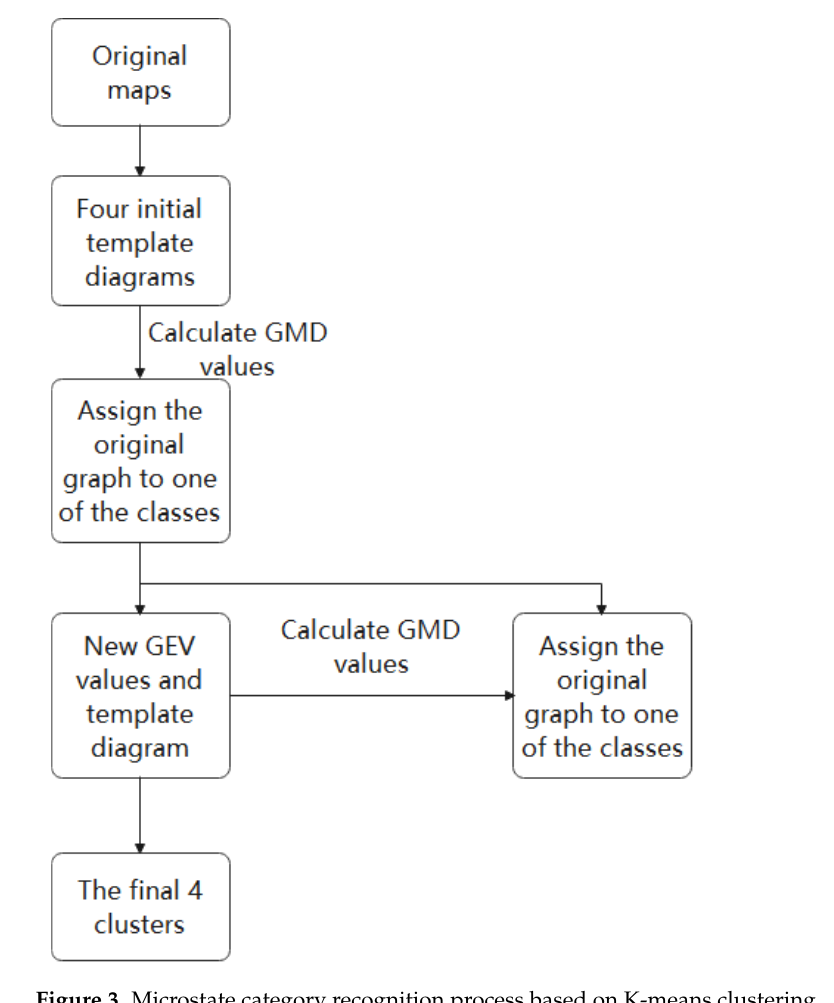
Figure 2. Flow chart of EEG microstate analysis. Each EEG datum point was used to calculate the GFP curve of each data point. We plotted the potential of all electrodes at the time of local maximum of the GFP curve to generate the original topographic map. The original maps were subjected to the clustering algorithm, which grouped submitted maps into a group of clusters (4 maps) according to the terrain similarity. Finally, the clustering map was inversely fitted to the GFP curve, and each data point was marked with the most relevant clustering map. Therefore, EEG signals were converted into EEG microstate sequences.